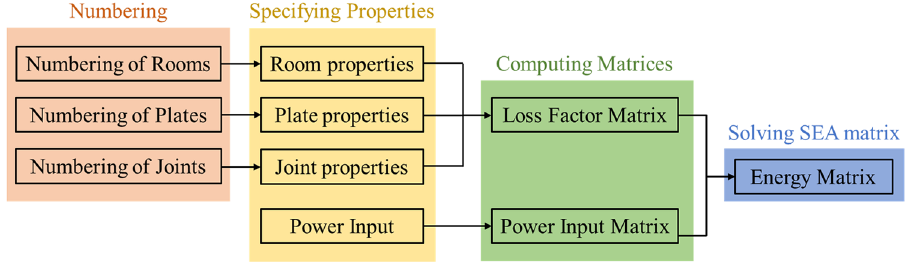
Fig. 5 Illustration of the general procedure of fast SEA model building